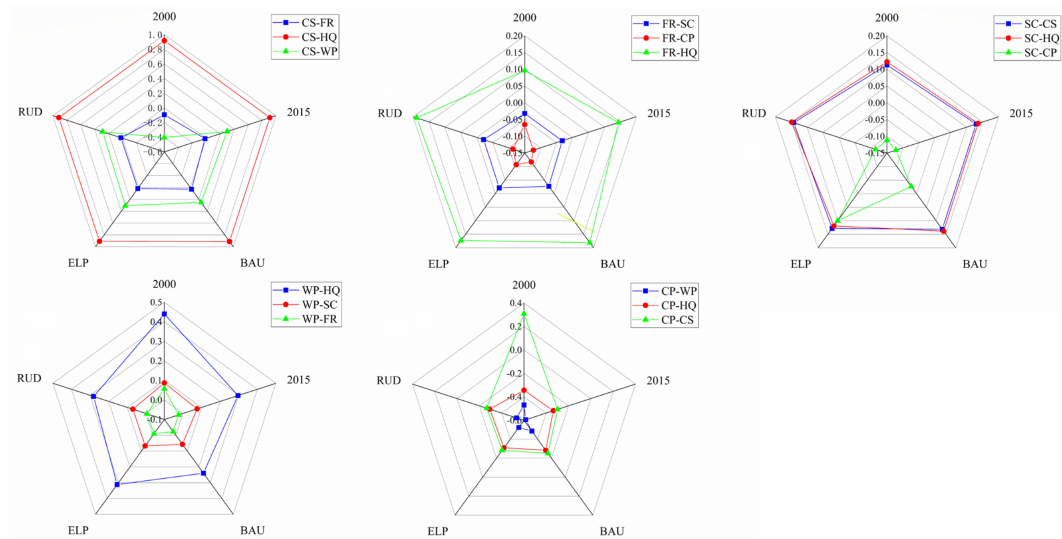
Figure 6. Radar plot of correlation coe ffi cients among ESs in 2000–2030 under di ff erent scenarios. (CS-carbon storage, FR-flood regulation, SC-soil conservation, WP-water purification, HQ-habitat quality, and CP-crop